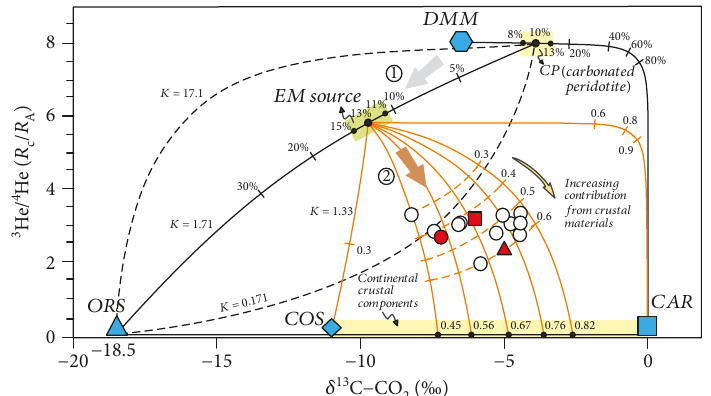
Figure 8: C-He isotope systematics showing a two-stage model for cold spring gases in WMVF. Stage 1: interactions between slab-derived melts (CAR and ORS) in MTZ and the depleted upper mantle (DMM); stage 2: the di ff erent proportions of crustal contribution (COS and CAR) during the ascending process of EM-derived volatiles. COS represents the continental organic metasediments. Table 3: Reference values for associated parameters of DMM, CAR, ORS, and COS end members used in C-He isotope systematics. ( ‰ End member δ 13 C CO2